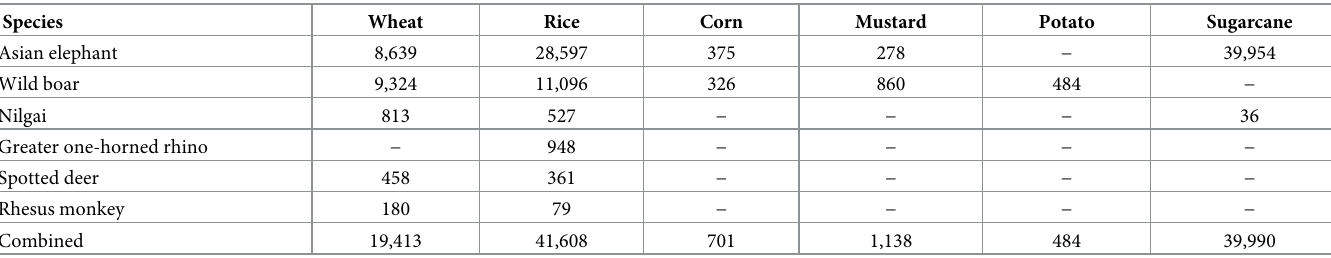
Table 4. Estimated value of reported crop damage (in USD) by wildlife, Shuklaphanta National Park, Nepal, 2016–2021. Species Wild boar Greater one-horned rhino Spotted